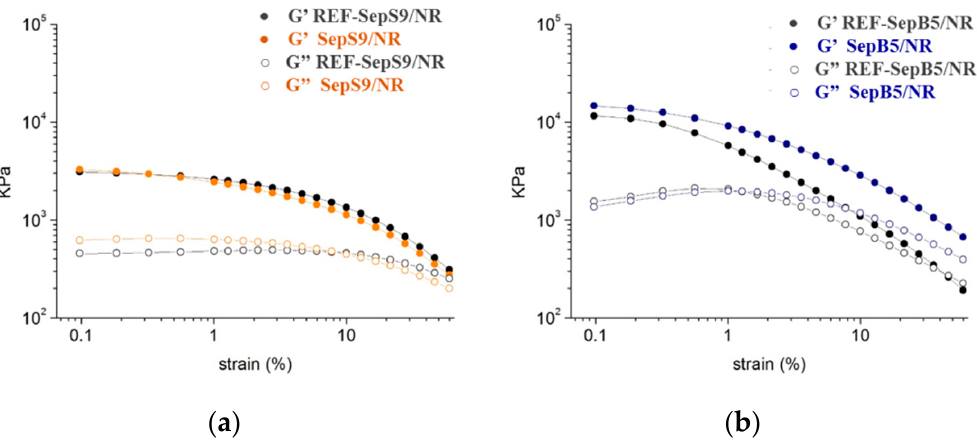
Figure 7. Storage modulus G’ (storage modulus, plain circle lines) and loss modulus G” (loss modulus, empty circle lines) vs strain for ( a ) NR/SepS9 biocomposite (orange lines), REF-SepS9/NR (Reference-Sepiolite S9/Natural Rubber) nanocomposite (black lines) and for ( b ) NR/SepB5 biocomposite (blue lines), REF-SepB5/NR (black lines).